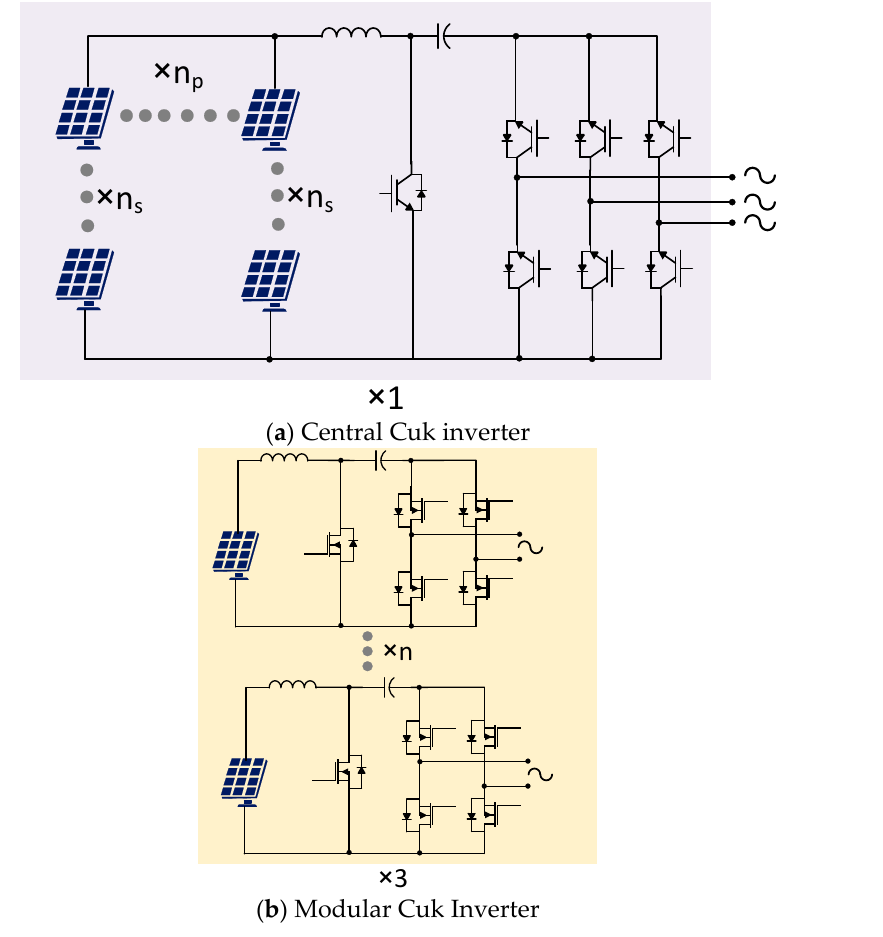
Figure 32. Central versus modular Cuk inverters. Table 6. Stresses and power losses of the Cuk central inverter.